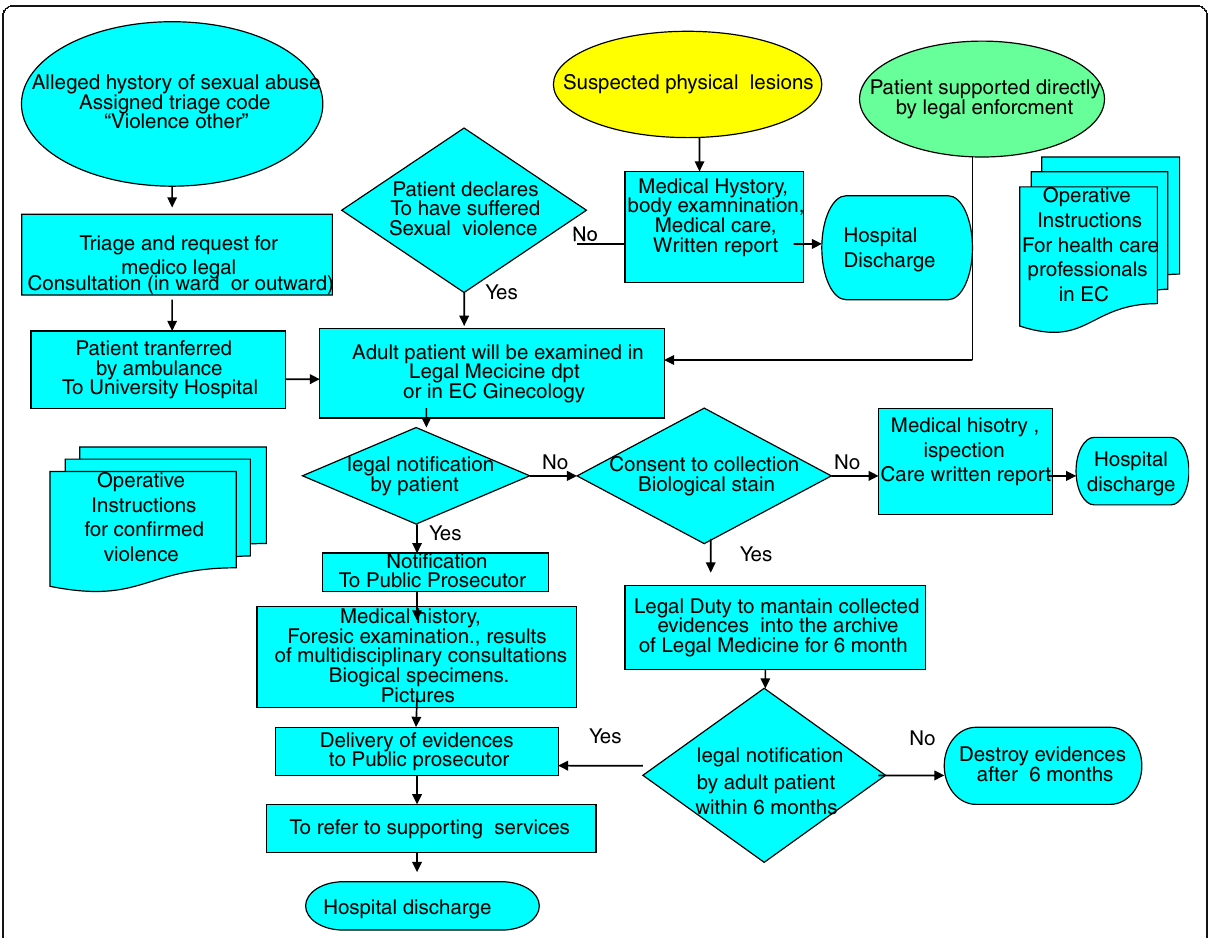
Fig. 1 Flow chart of procedure for taking care of alleged victim within